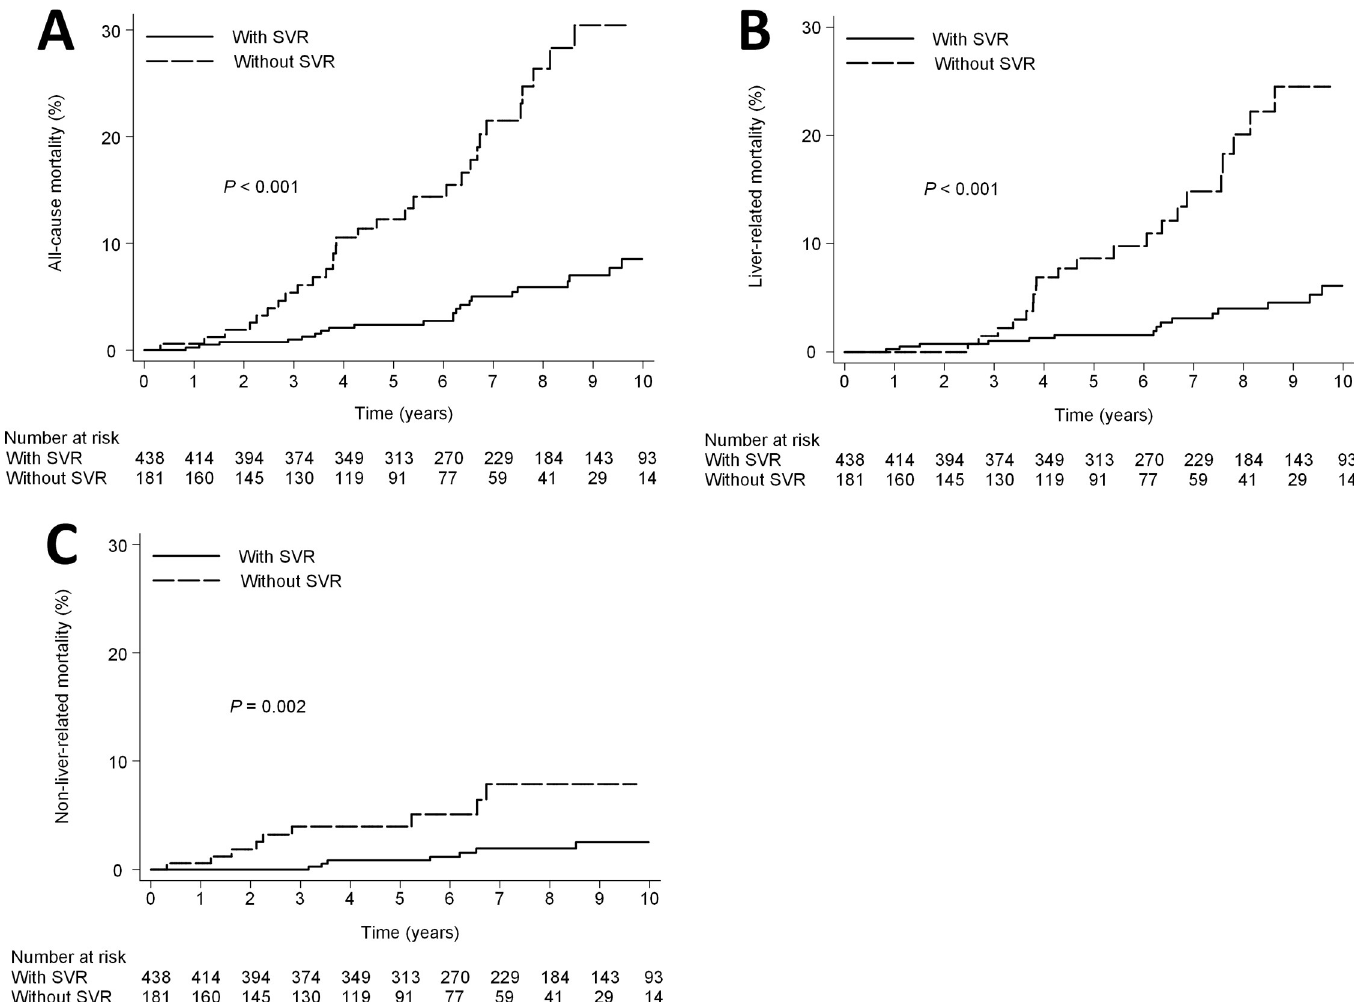
Fig 7. Mortality according to SVR in advanced fibrotic patients. (A) all-cause mortality (10- year mortality rate, 8.5% vs 30.4%; HR, 0.2; 95% CI, 0.12–0.35; P < 0.001). (B) liver-related mortality (10- year mortality rate, 6.1% vs 24.5%; HR, 0.2; 95% CI, 0.10–0.38; P < 0.001). (C) non-liver-related mortality (10- year mortality rate, 2.5% vs 7.9%; HR, 0.21; 95% CI, 0.08–0.56; P =